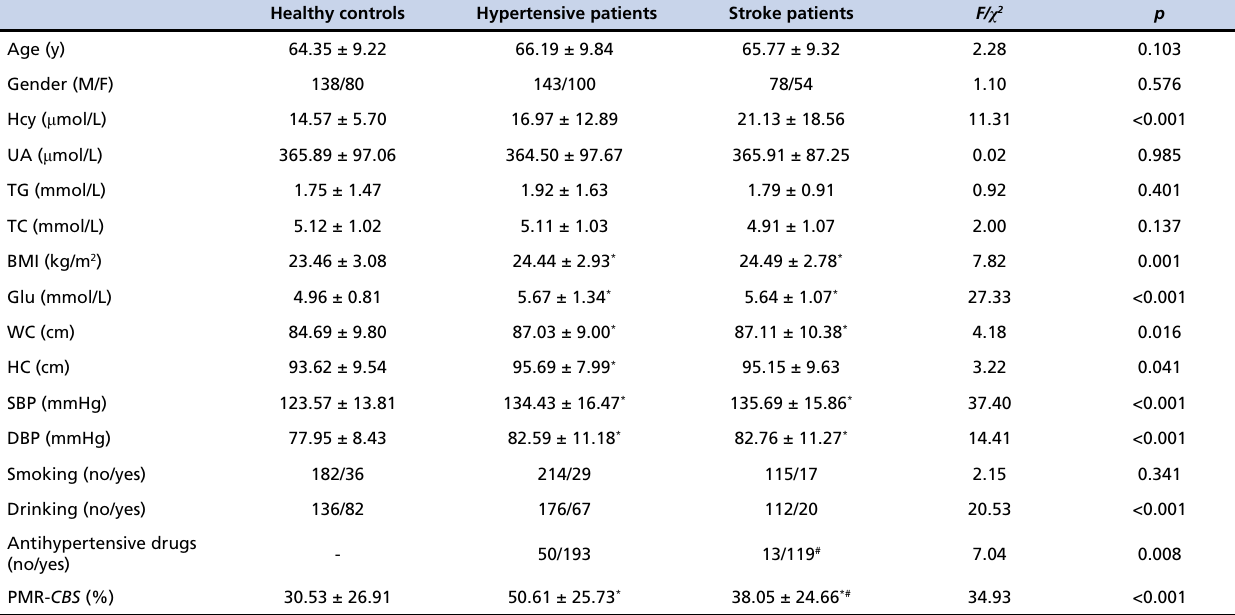
Table 1 - Baseline characteristics of healthy controls, hypertensive patients, and stroke patients.